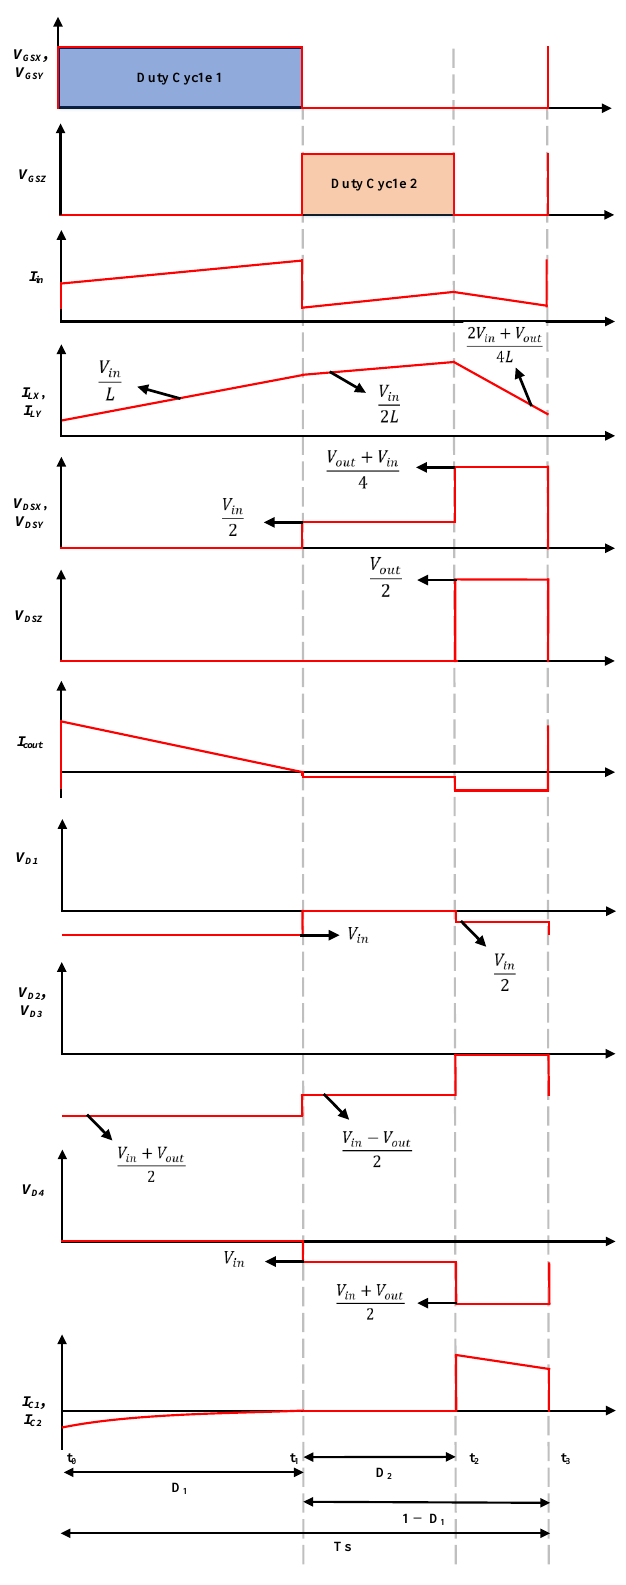
Figure 2. CCM operation of the proposed DC–DC boost converter